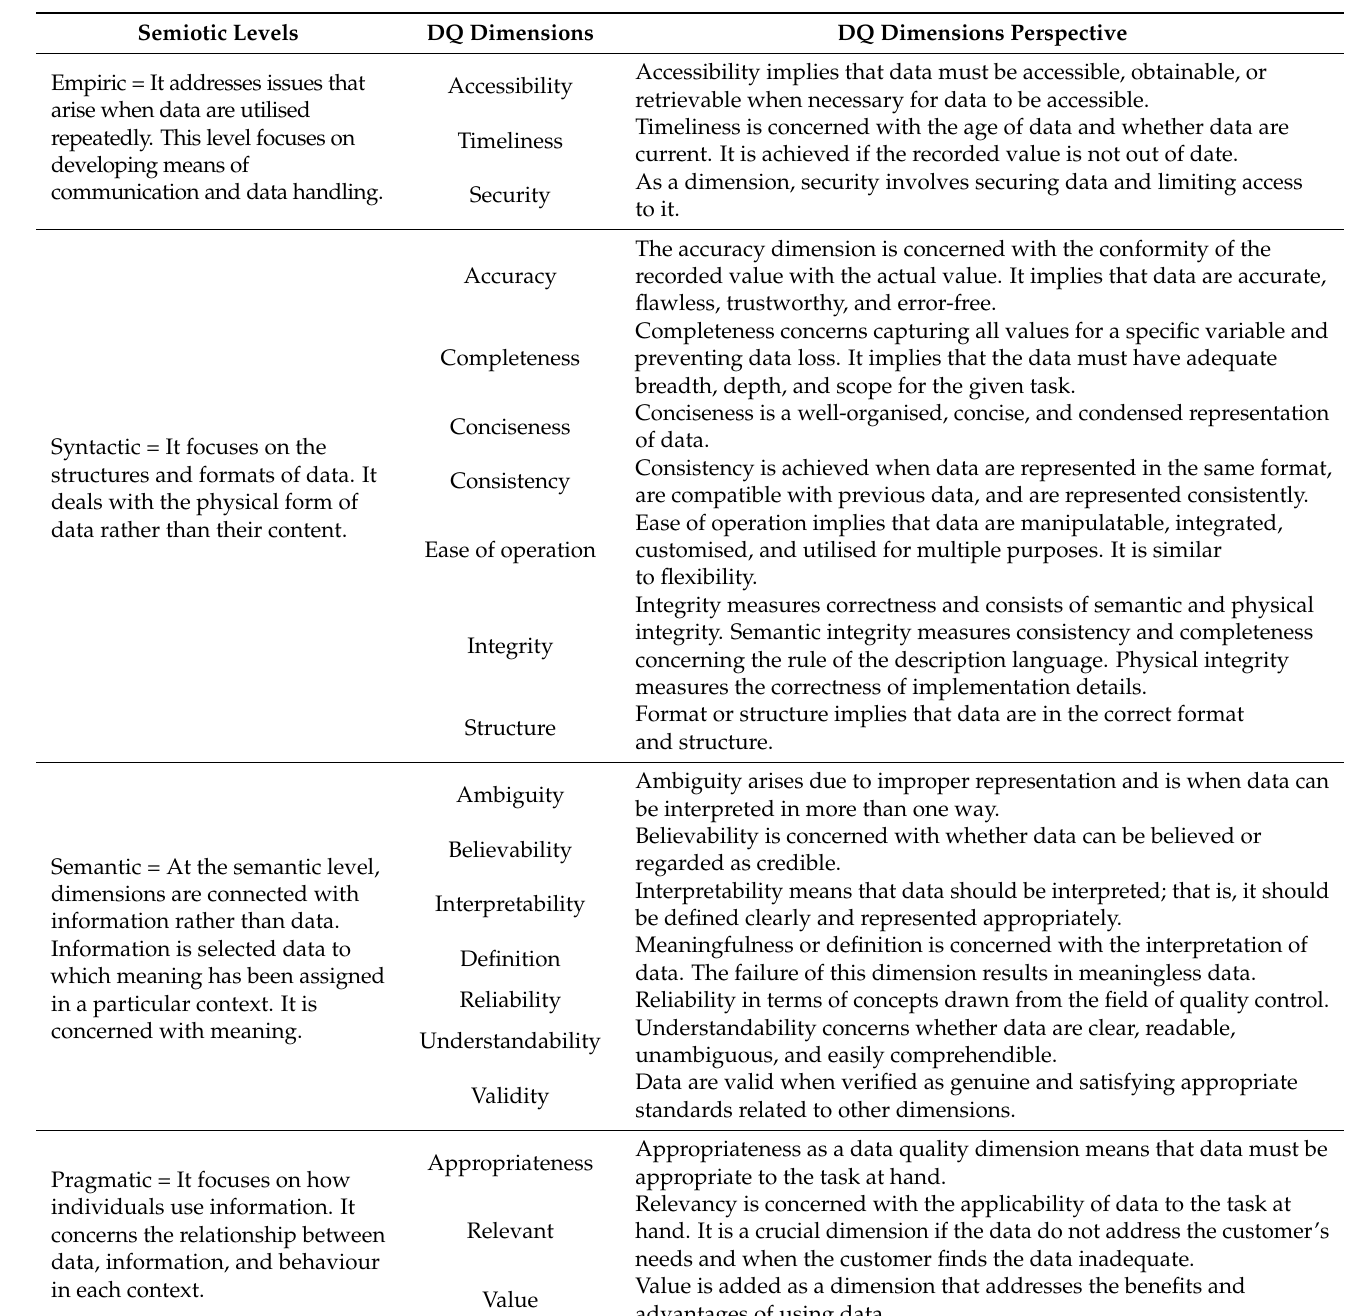
Table 2. Data quality (DQ) dimensions and perspectives as per the semiotic framework